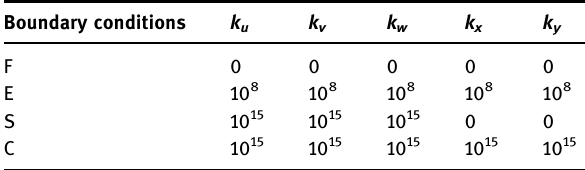
Table 1: The spring sti ff ness values of the general edge conditions Boundary conditions